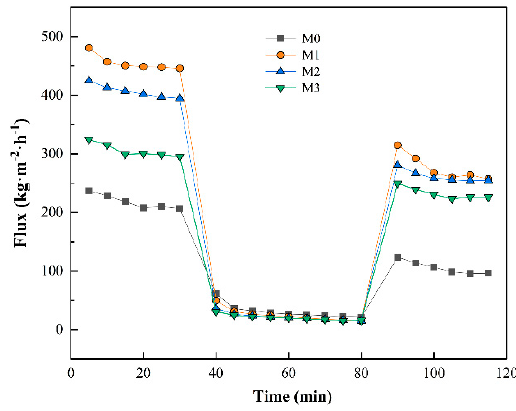
Figure 9. Time-dependent fluctuation of pure water flux and BSA solution flux.